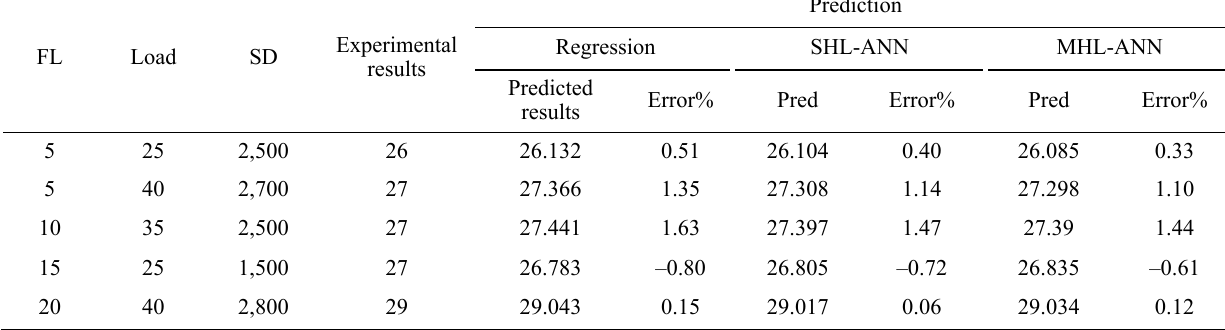
Table 22 Confirmatory tests for temperature.